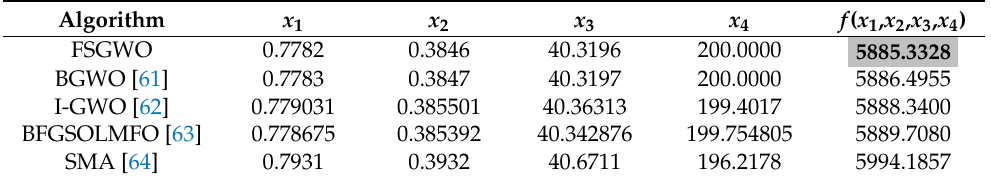
Table 15. Results of related algorithms for the pressure vessel design problem.